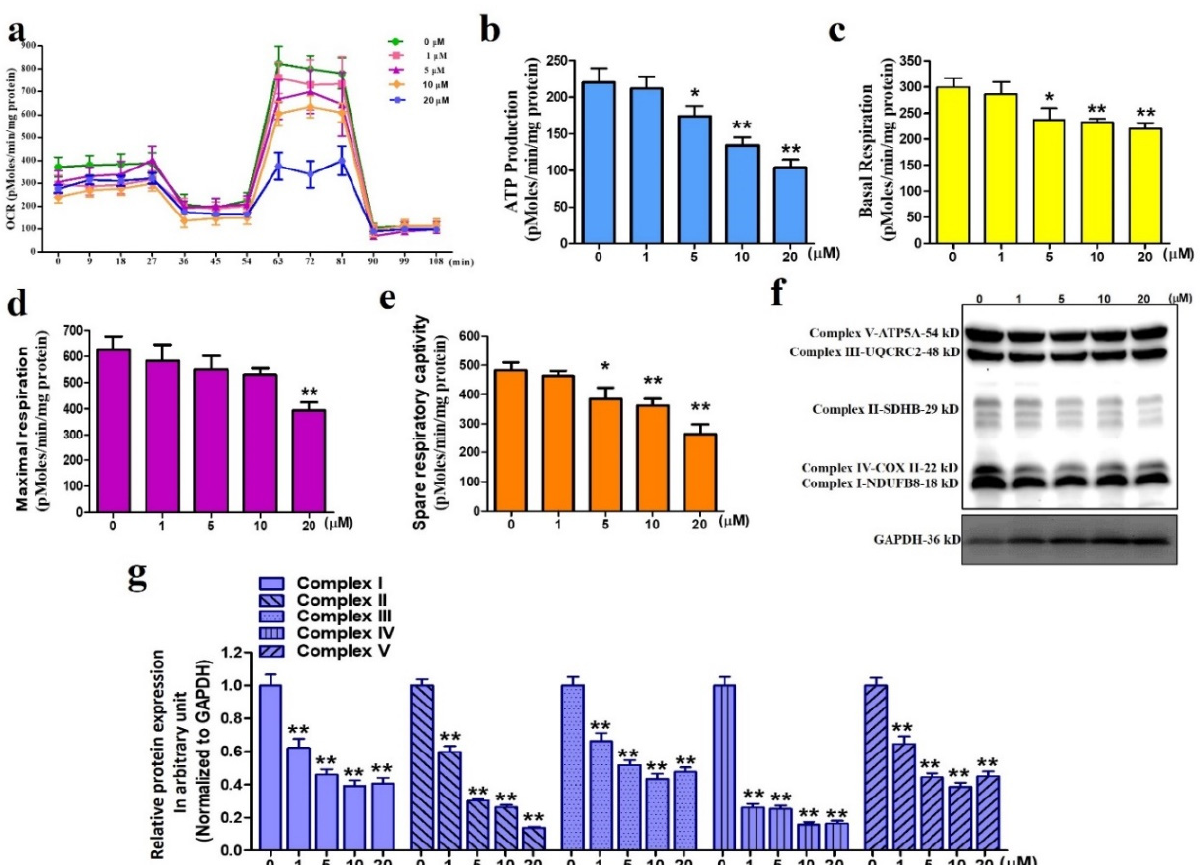
Figure 4. Changes in oxygen consumption rates and enzymatic complexes I to V of the OXPHOS electron transport chain. ( a ) Measurements of oxygen consumption rates. ( b ) Analysis of ATP production. ( c ) Analysis of basal respiration. ( d ) Analysis of maximal respiration. ( e ) Analysis of spare respiration capacity. ( f ) Western blot measurement of the enzymatic complexes I to V. Full, uncropped Western blot gel can be found on Supplementary File Figure S2a. ( g ) Analysis of the enzymatic complexes I to V. Each bar represents the mean ± standard error of the mean. * p < 0.05 and ** p < 0.01 relative to